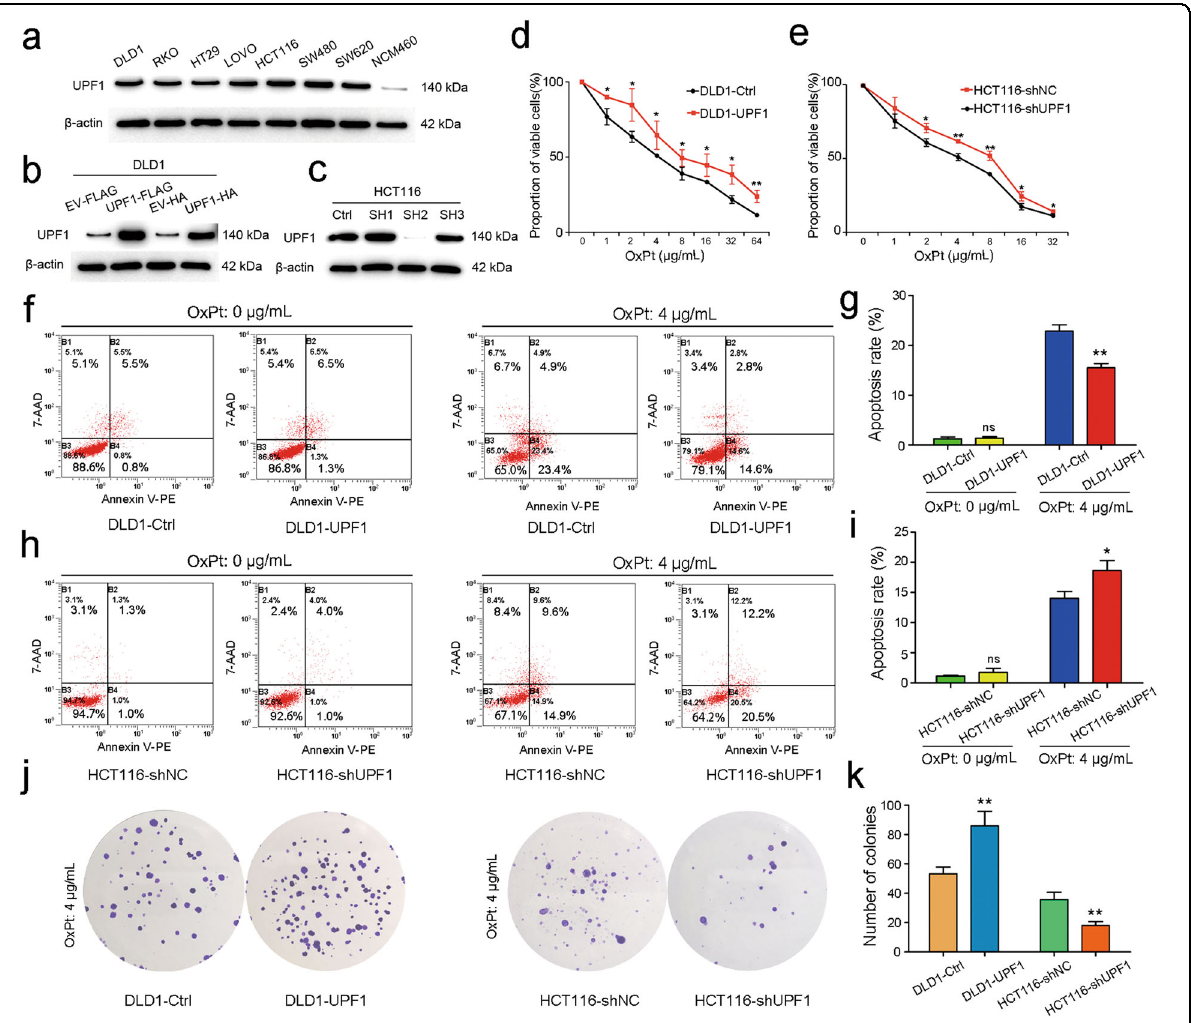
Fig. 2 UPF1 induced chemoresistance to oxaliplatin (OxPt) in CRC in vitro. a The baseline expression of UPF1 in CRC cell lines and normal colonic epithelial cell line detected by Western blot. b – c Overexpression and knockdown of UPF1 in DLD1 and HCT116, respectively. d – e Cell viability of stable CRC cell lines treated with a gradient concentration of oxaliplatin assessed by CCK-8 assay. f – i Apoptosis rate of stable CRC cell lines treated with or without oxaliplatin assessed by fl ow cytometry. j – k Clone formation of stable CRC cell lines treated with